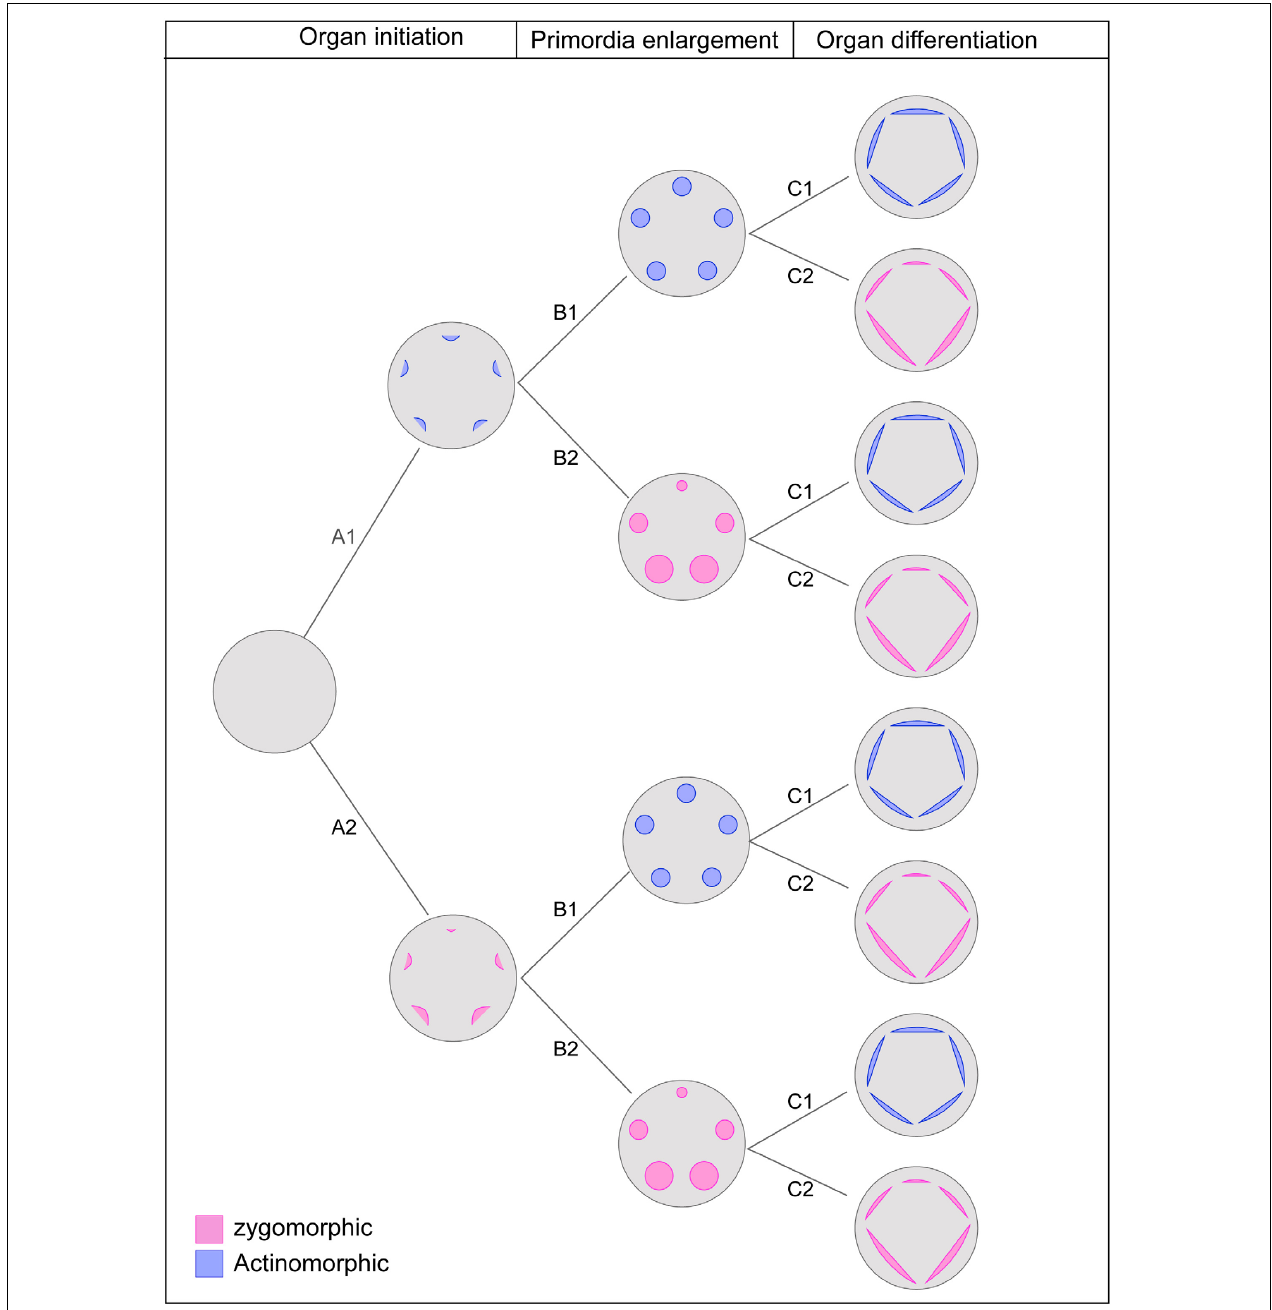
FIGURE 6 | The theoretical pathway of symmetry establishment considering three independent developmental stages with two possible expression of actinomorphy or zygomorphy at each stage. The combination of possible changes results in eight pattern of symmetry expression: Early expression of actinomorphy: A1-B1-C1; Late expression of zygomorphy: A1-B1-C2; Late expression of actinomorphy with a shift at mid stage: A1-B2-C1; Mid-stage expression of zygomorphy: A1-B2-C2; Mid-stage expression of actinomorphy: A2-B1-C1; Late expression of zygomorphy with a shift at mid stage: A2-B2-C1; Late expression of actinomorphy: A2-B2-C1; Early expression of Zygomorphy: